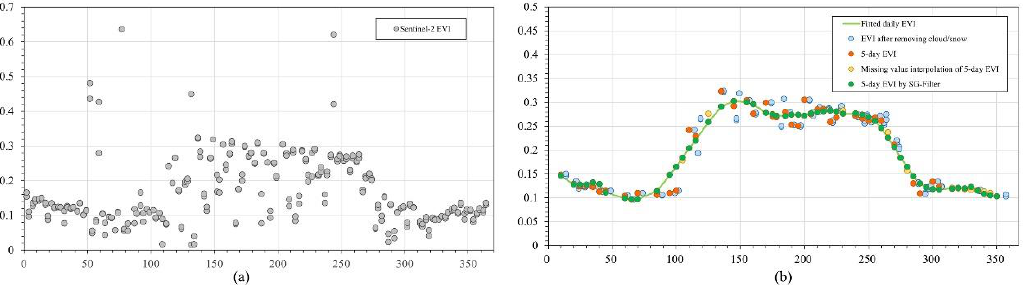
Figure 4. Sketch maps of time-series EVI reconstruction. ( a ) All the available Sentinel-2 EVI data without the removal of cloud/shadow; ( b ) reconstructed EVI.